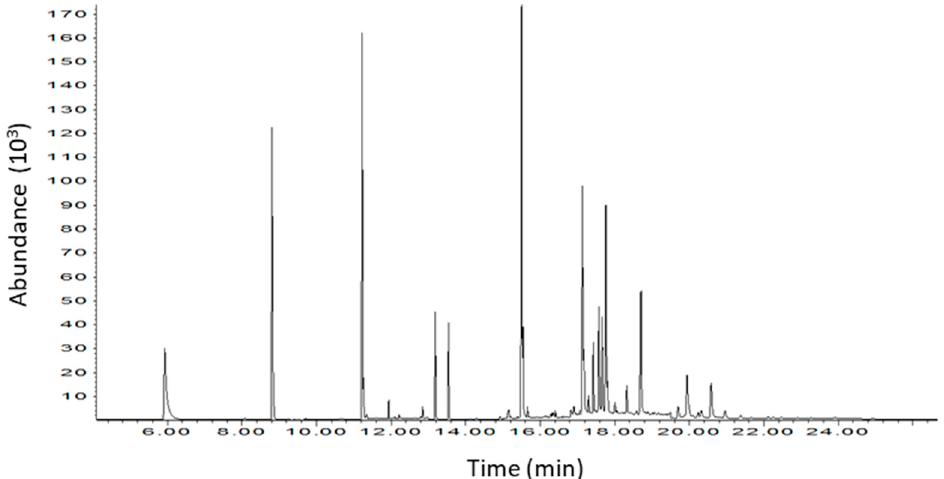
PAH quantification was carried out by using GC-MS. A representative chromatogram of a soil sample was included in Figure A1.